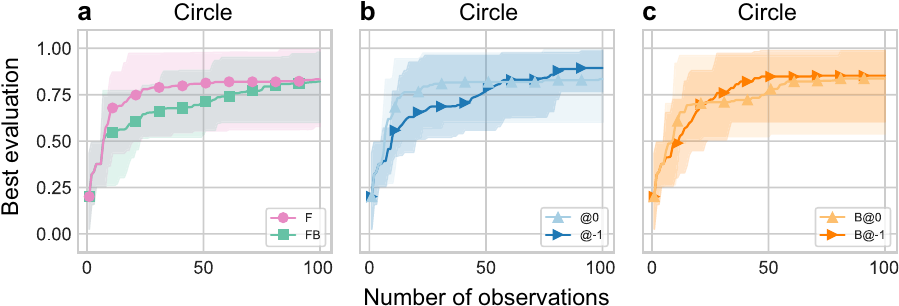
Fig. 2 Parameter search results for the Circle function. Best evaluation values averaged over fi ve runs as a function of the number of observations. Shaded areas indicate the range of the best and worst values of fi ve runs. a Methods F and FB that adaptively replace failed evaluations by the fl oor padding. b Baseline methods that use a constant value for the failed evaluations. Method @0 used the fi xed value of 0 when the experiment failed, whereas @ − 1 used − 1. c Methods with classi fi er while padding a constant to failures. B@0 used a value of 0 as the evaluation when the experiment failed, whereas B@ − 1 used − 1.